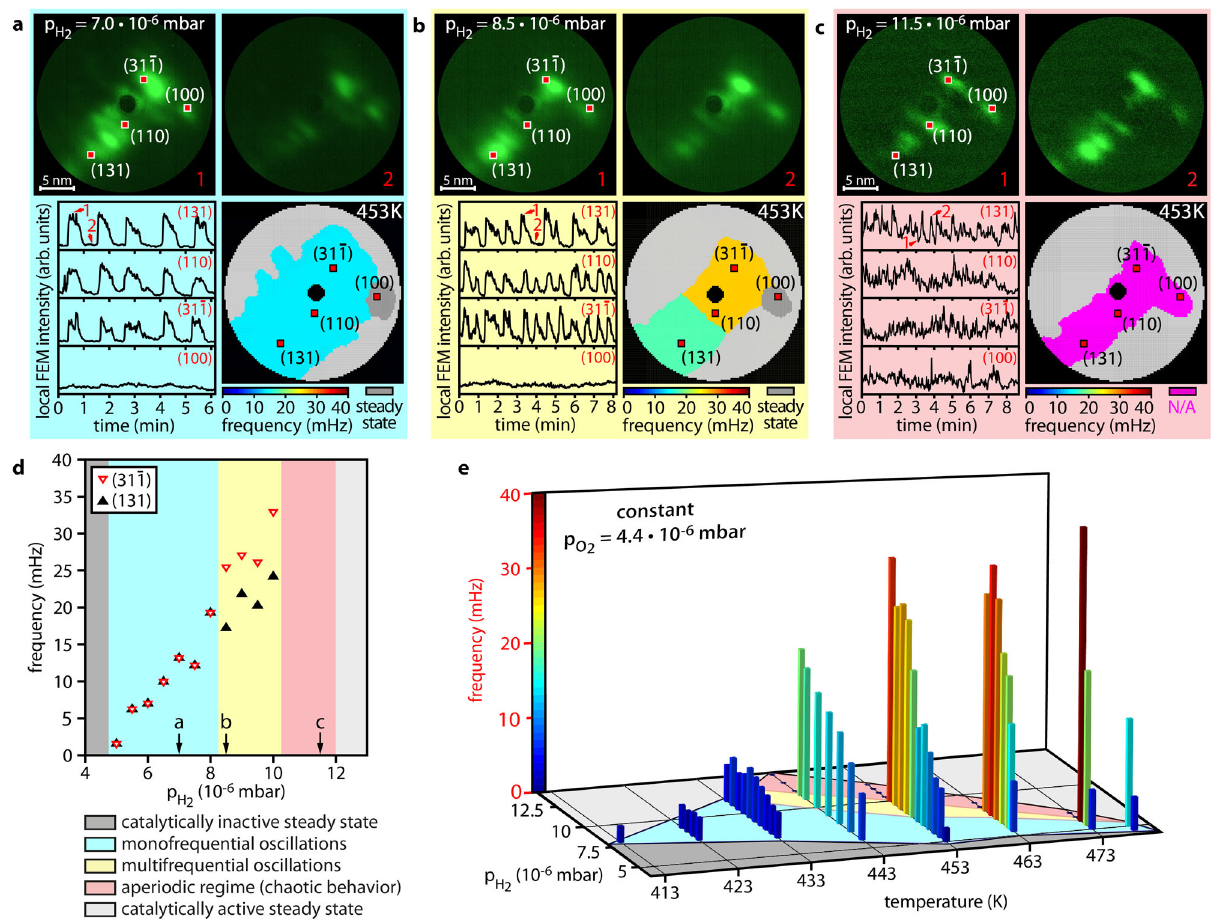
− 6 mbar and 453K. d Pressure dependence of the oscillation fre- p H2 =11.5×10 quencies within the (131) and ð 31 (cid:1) 1 Þ ROIs at 453K. Colour codes separate regions of different modes. Black arrows indicate the p H2 -values corresponding to a – c , respectively. e Diagram illustrating the existence ranges of the observed reactionmodes.Differentstatesare colour-coded thesame wayasin d .Theheight and colour of the bars represent the oscillation